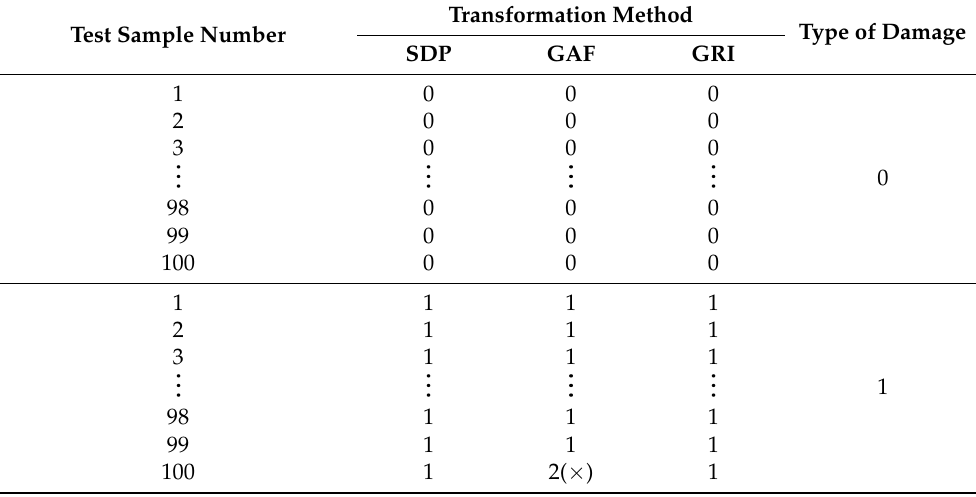
Figure 3. Loss degree change curve of model training set. Table 4. The state recognition results of bearing test set for different image transformation